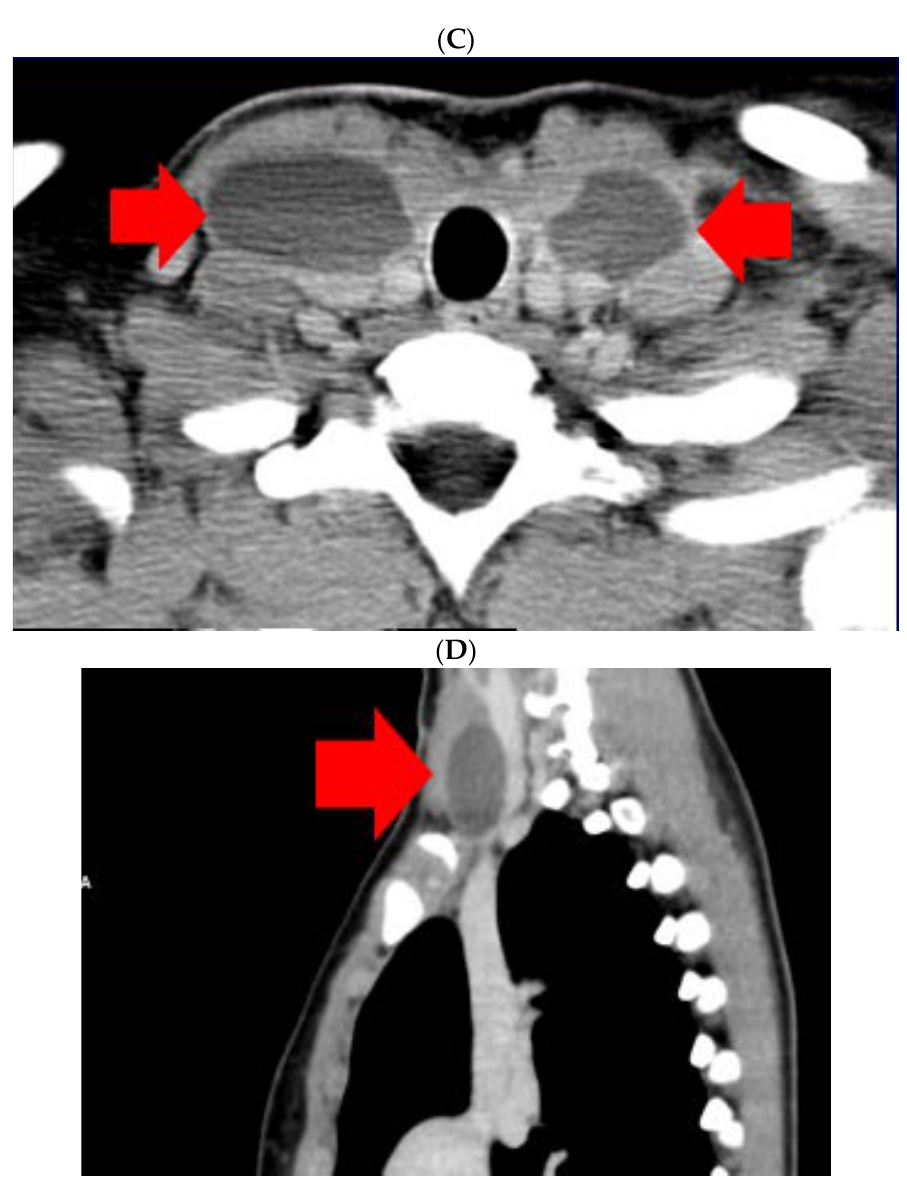
Figure 3. Computer tomography of neck area showing bilateral lateral cervical well-shaped masses with cystic features of 4 by 2.5 by 5.74 cm on the right, respective of 1.6/2.7/4 cm on the left (5 weeks since surgery, before any local intervention). ( A ). Frontal plane—first section; ( B ). Frontal plane—second section; ( C ). Transverse plane; ( D ). Sagittal plane.